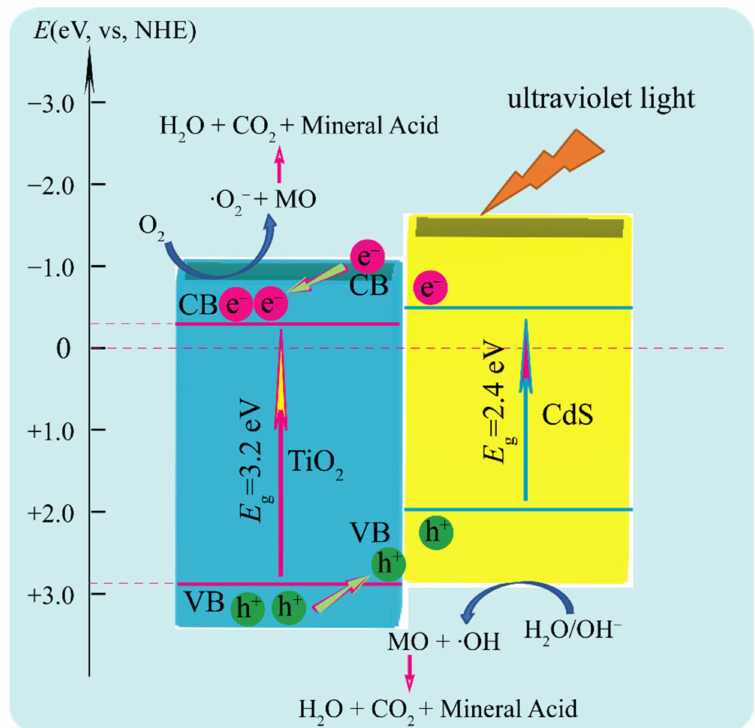
Figure 10. Possible photocatalytic mechanism of TiO 2 /CdS nanocomposites for the photodegradation of MO under ultraviolet light